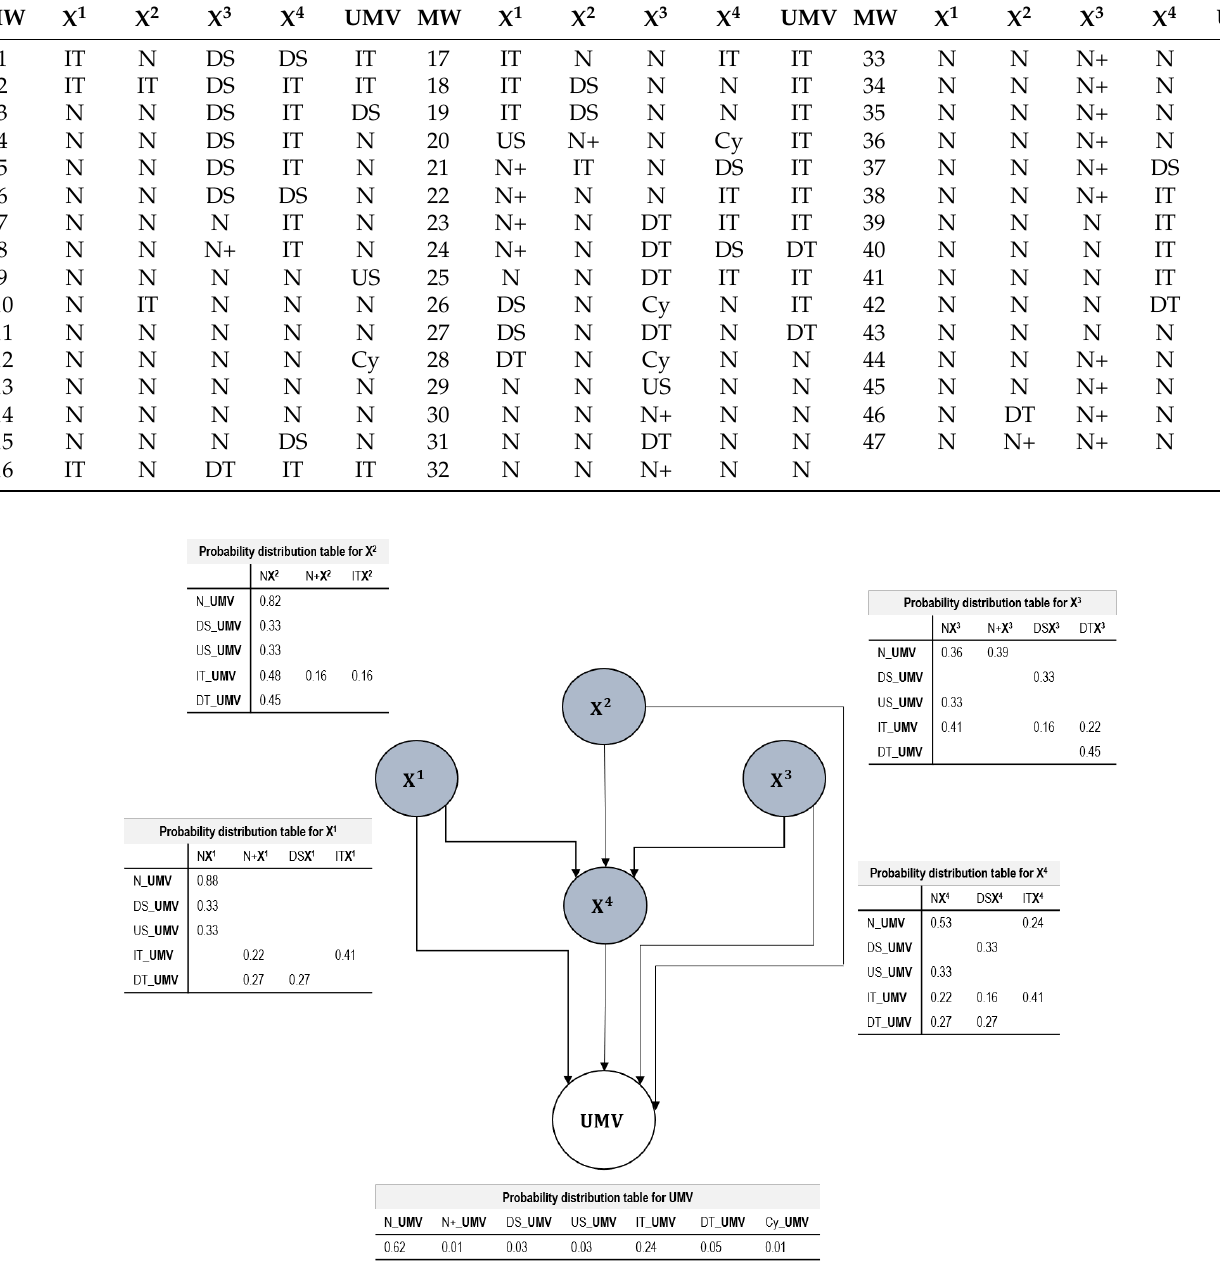
Figure 5. Bayesian Network diagram for variables from the first